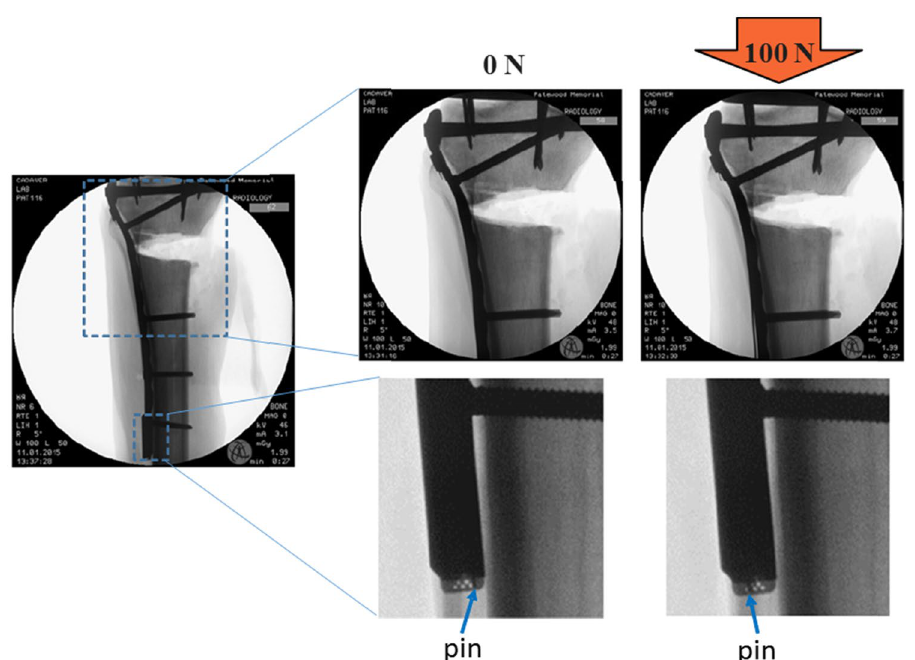
Figure 4. Radiographic images of the Sensor. The implant, fracture gap, and passive strain sensor are shown for both unloaded and 100 N compression loaded cases in a human cadaver tibia. The indicator pin moves from below hole 1 to covering hole 4 under the 100 N